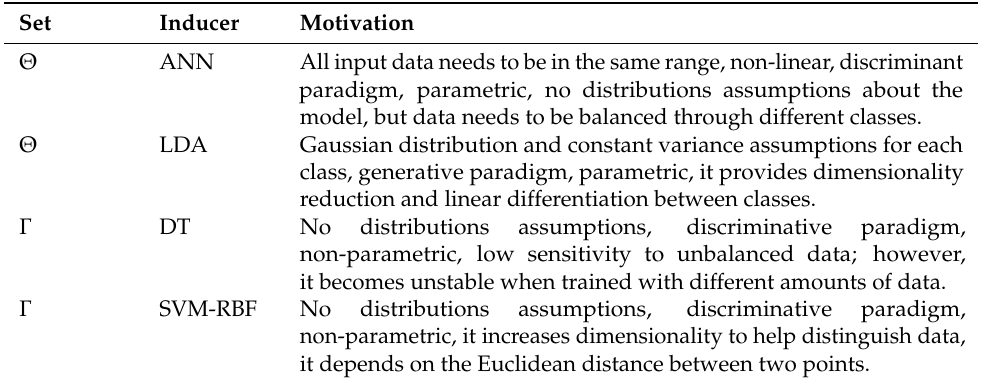
Table 7. Selected